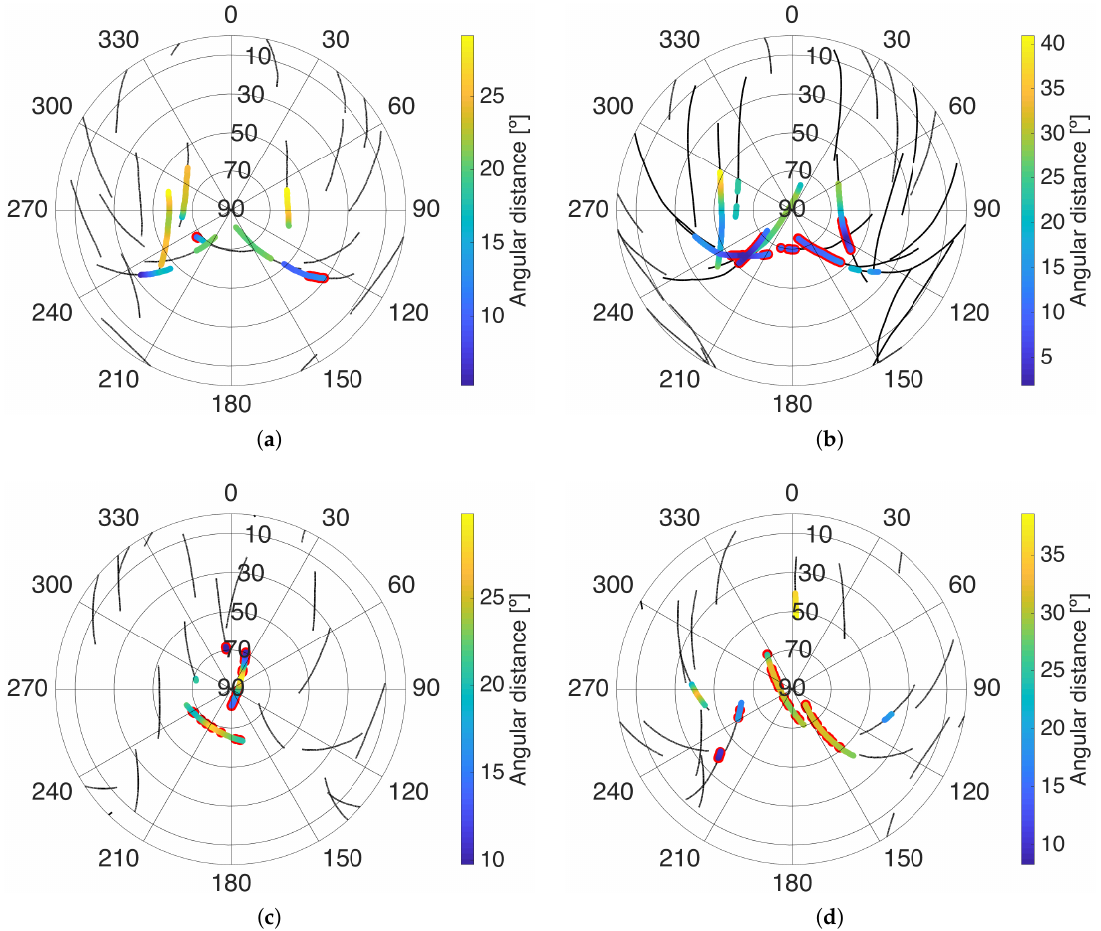
Figure 4. Skyplot of the tracked satellites in the ( a ) flight over the entrance to Port Philip Bay, ( b ) sea flight over the Bass Strait, and flights over Yanco under dry ( c ) and wet ( d ) soil conditions. The color scale indicates the angular distance to the closest satellite. Red lines highlight cross-talk from other satellites.